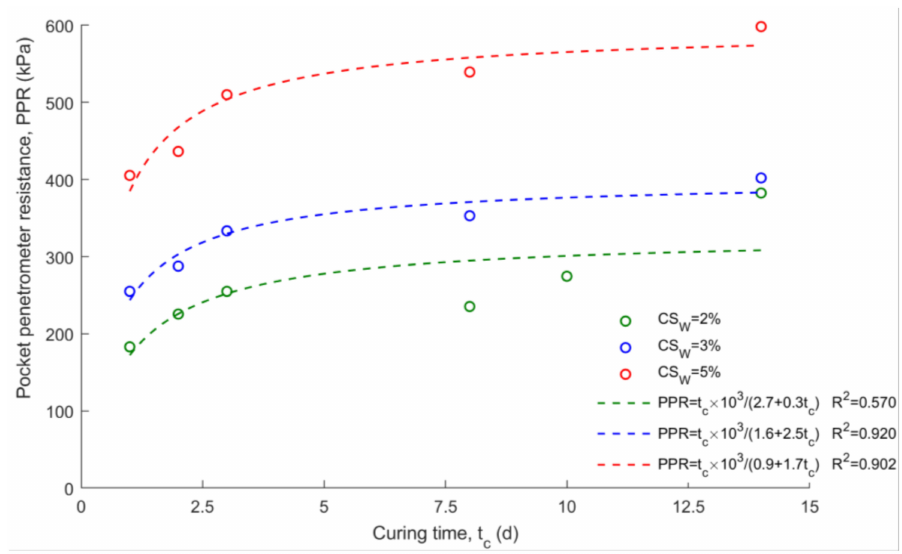
Figure 13. Pocket penetrometer resistance of CS-treated sand versus curing time for different CS contents (mod. from